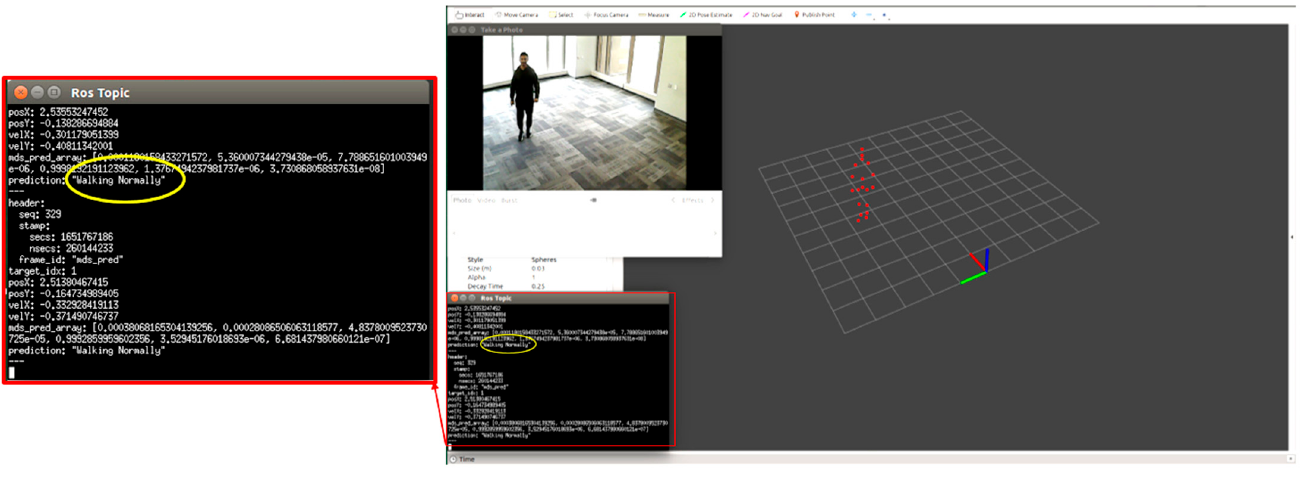
Figure 12. Subject walking normally.